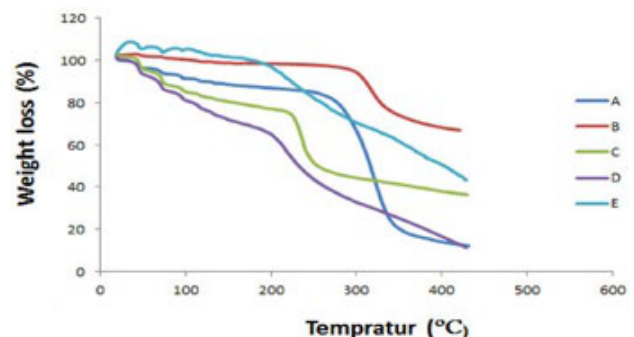
FIGURE 5 - TGA curves of Ofloxacin (A); Chitosan (B); Alginate (C); Chitosan/TPP nanoparticles (D); Chitosan/TPP- Alginate nanoparticles (E).